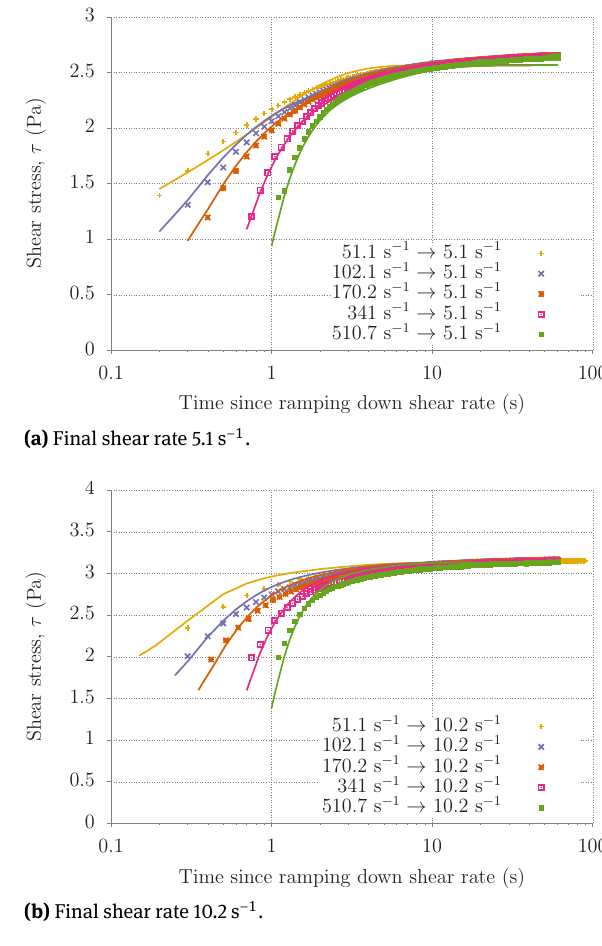
Figure 7: Measurements and model predictions for shear stresses in the OBM following shear rate steps down to shear rates of 5.1 s −1 and 10.2 s −1